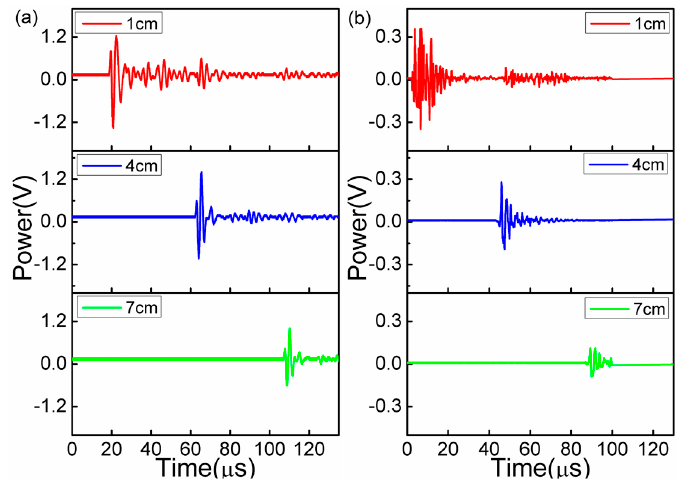
Figure 3. Time domain spectra of ( a ) 300 kHz and ( b ) 1 MHz UW versus increasing distances between PZT and sensor.